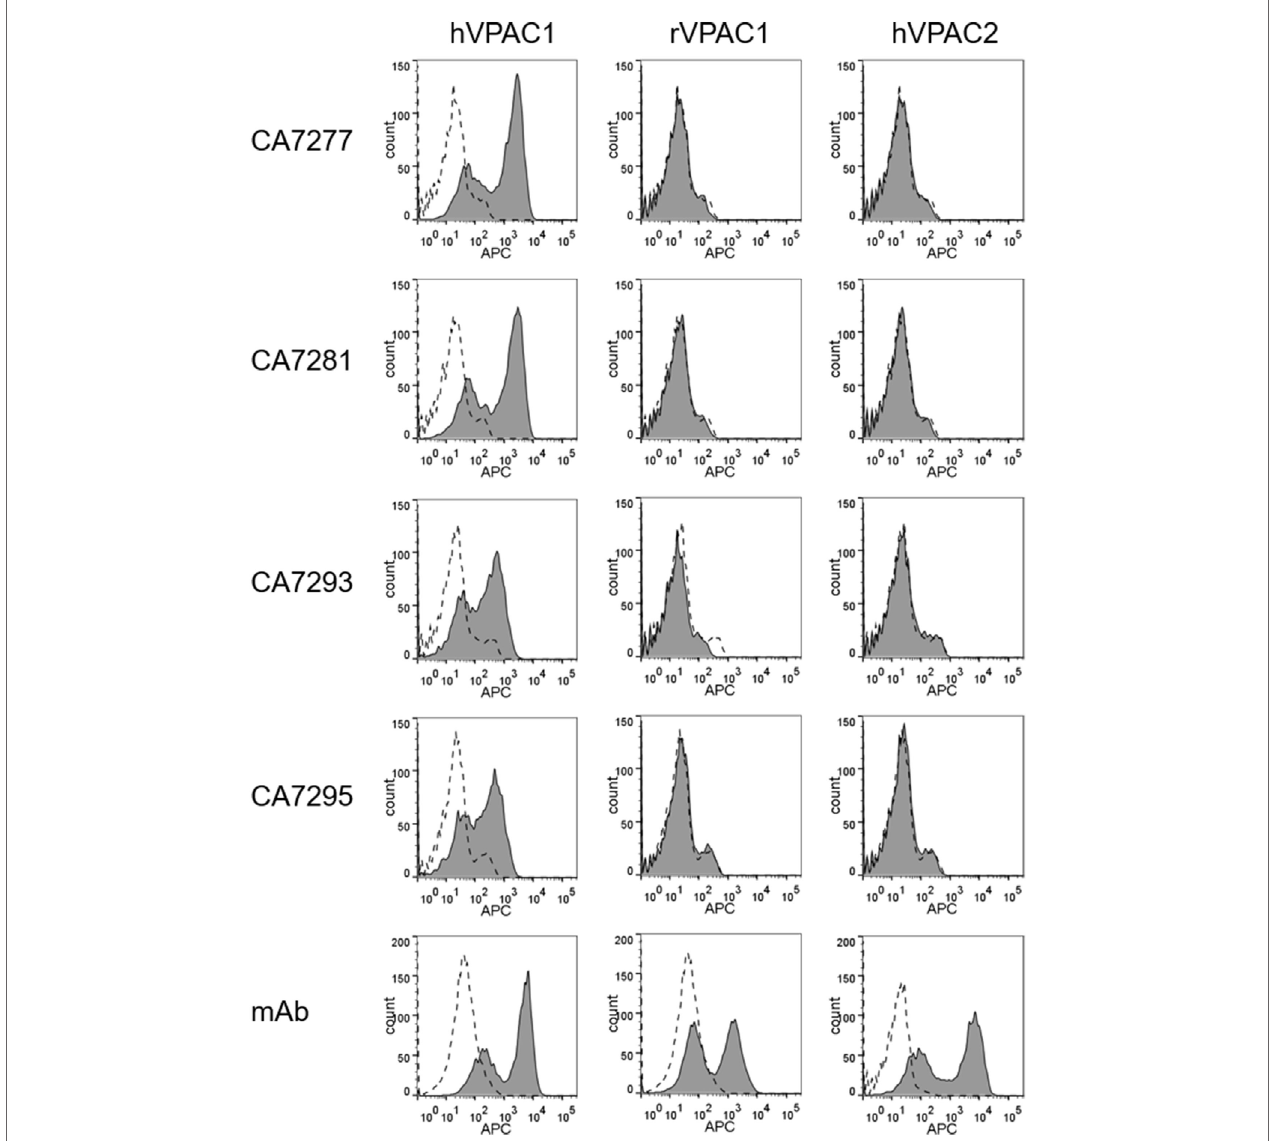
FigUre 1 | Assessment of nanobody specificity. The specificity of the nanobodies was investigated by FACS using human embryonic kidney cells-297T cells transiently transfected with empty plasmid (dotted lines) or plasmids encoding human VPAC1, rat VPAC1 or human VPAC2 (filled histograms). The cells were incubated with a reference mouse monoclonal antibodies (mAb) for each receptor (bottom panels) or DyLight 650-conjugated nanobodies. Bound mAbs was detected with an APC-conjugated secondary antibody. The data are representative of three independent